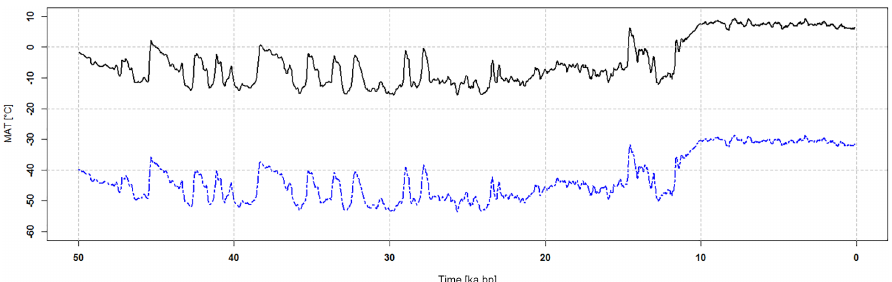
Figure 2. Derived mean annual temperature (MAT) data for the GISP2 location (dashed line) (after Alley, 2000) and the assumed curve for the test site at Ebergötzen (solid